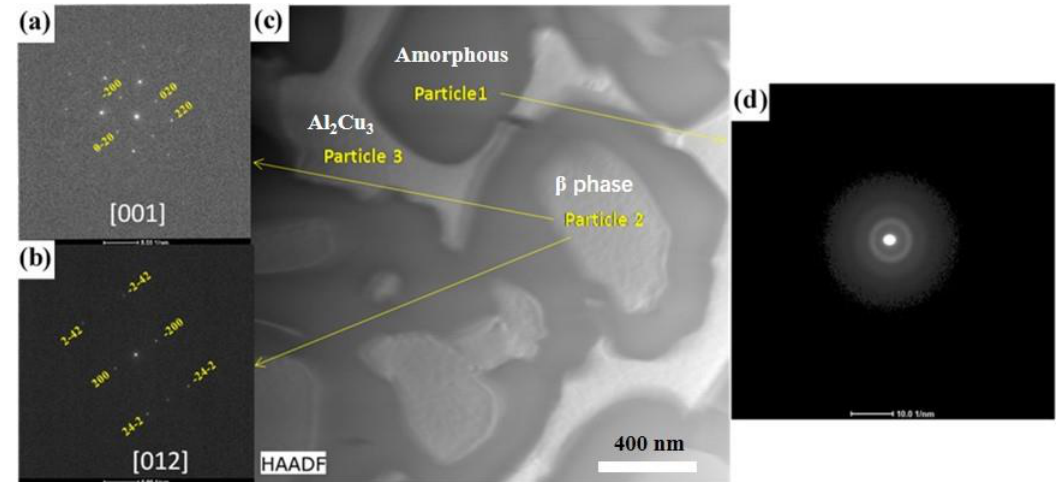
Figure 3. ( a ) Selected area electron diffraction (SAED) pattern of the CsCl type β-Al(Cu, Fe, Si) phase along the [001] zone axis; ( b ) SAED pattern of the β-Al(Cu, Fe, Si) phase along the [012] zone axis; ( c ) high-angle annular dark-field imaging (HAADF) image of Al 50 Cu 20 Fe 15 Si 15 powder; ( d ) diffraction pattern of the amorphous phase. Table 2. EDS results of different powder phases.